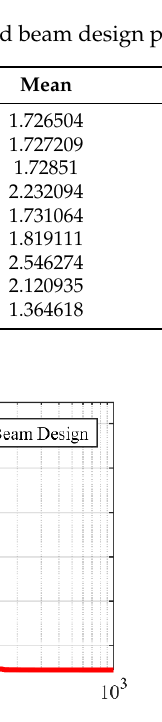
Table 14. Statistical results for welded beam design problem.